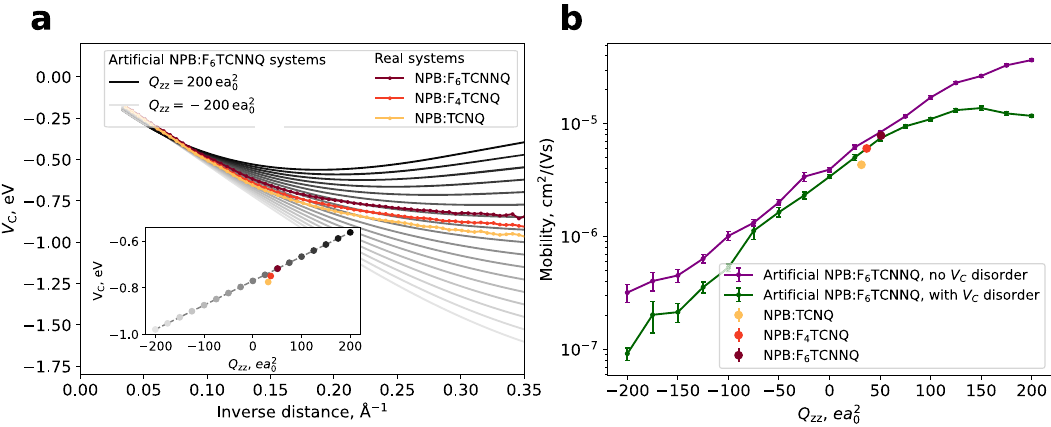
Fig.3|Tuningholemobilityusingshort-rangeoverscreeningeffect.a Distance- dependent V C forNPBdopedwith5mol%TCNQ,F 4 TCNQ,F 6 TCNNQ(color)andfor dopants with arti fi cially modi fi ed quadrupole Q zz between − 200 ea 2 0 and 200 ea 2 0 (gray, darker means larger Q zz in steps of 25 ea 2 0 ). An increase in overscreening is observed for positive quadrupoles, negative quadrupoles diminish the